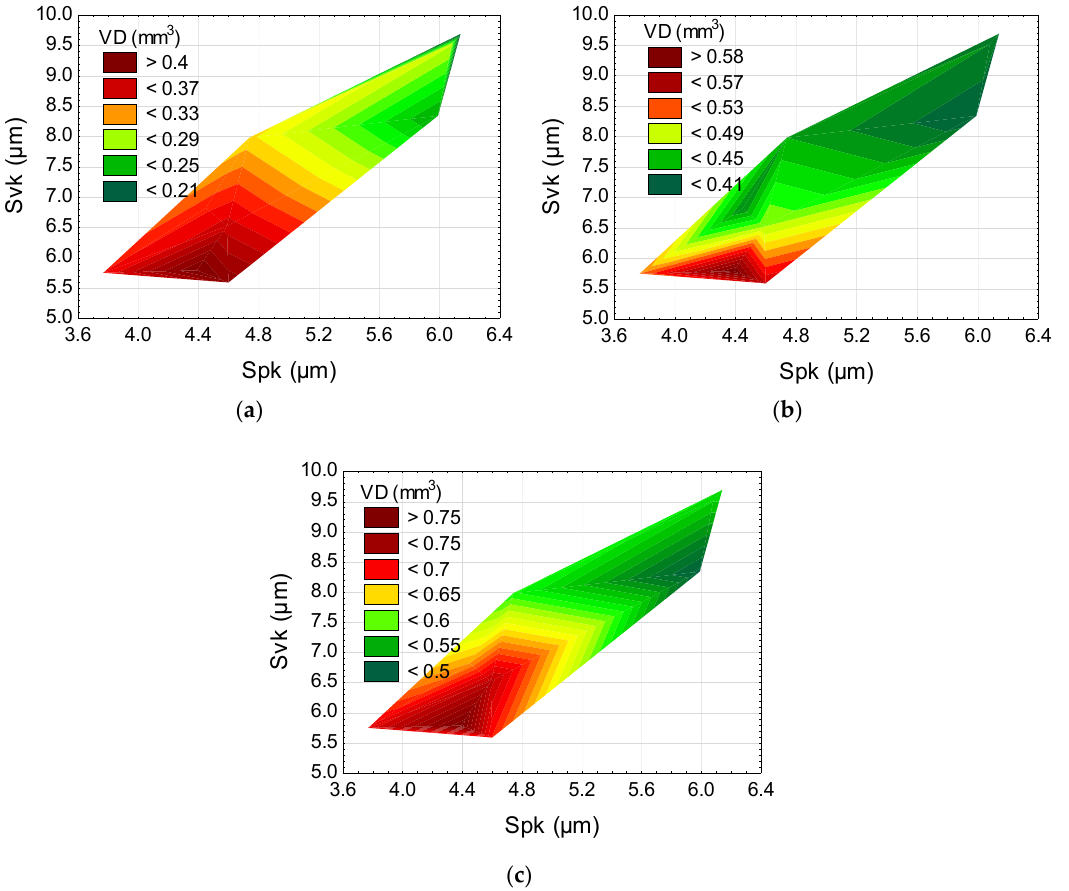
Figure 10. Dependencies between wear volume VD and Spk and Svk parameters at the sliding speed of v = 0.16 m/s ( a ), v = 0.32 m/s ( b ), v = 0.48 m/s ( c ).